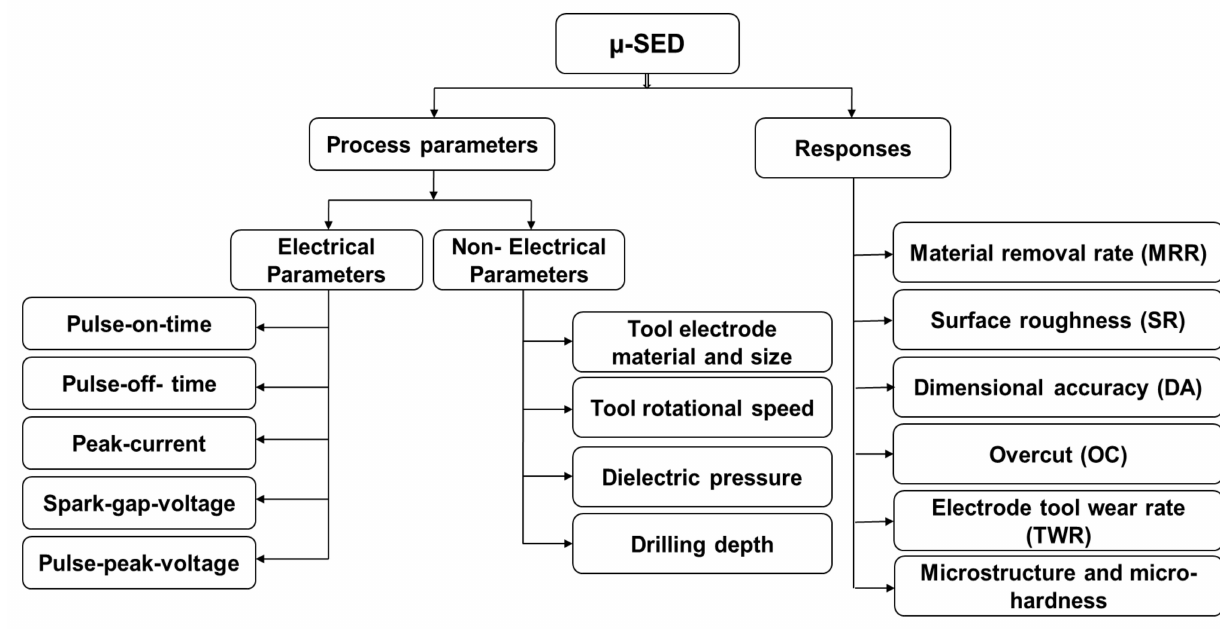
Figure 9. Micro spark-erosion drilling ( µ -SED) process parameters and